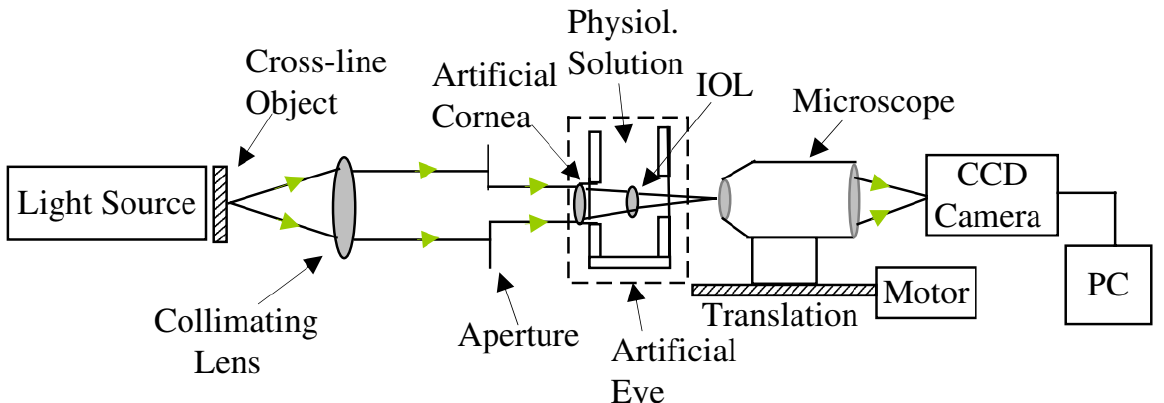
Figure 4. Schematic diagram of the eye model configuration used by Artigas et al, based on the ISO standards. Journal of Cataract and Refractive Surgery 2007, 33, 2111–2117 ([25]). Originally published by and reprinted with permission from Lippincott Williams & Wilkins, Inc.Norrby et al. [23] created and implemented one of their theoretical models as a physical device for MTF measurements (Figure 5). It seemed very simple and had the interesting characteristic of being packed into a very small enclosure, which could easily fit in different experimental setups. A CCD camera and suitable relay optics would simulate what the patient sees. The authors also mentioned the possibility of modifying it for wavefront measurements by using a diffusing retina, suggesting it could be used both for wavefront and single-pass measurements. Other single-pass models have been presented before as multi-modal cases [23,28]. Additional single-pass models for image formation will be presented in a later section dedicated to human vision.